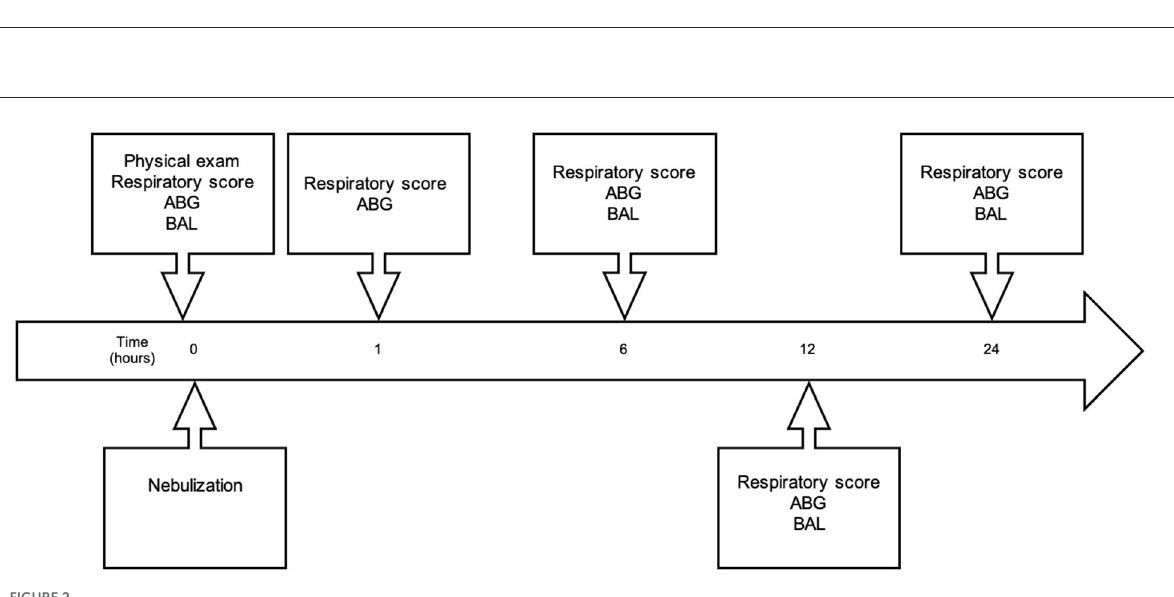
FIGURE1 Timeline of experimental periods. Horses were housed together on the same pasture for 18 days, before being moved to a climate-controlled closed barn for the duration of the experimental procedures. Horses were returned to the same pasture for the 14-day washout period.